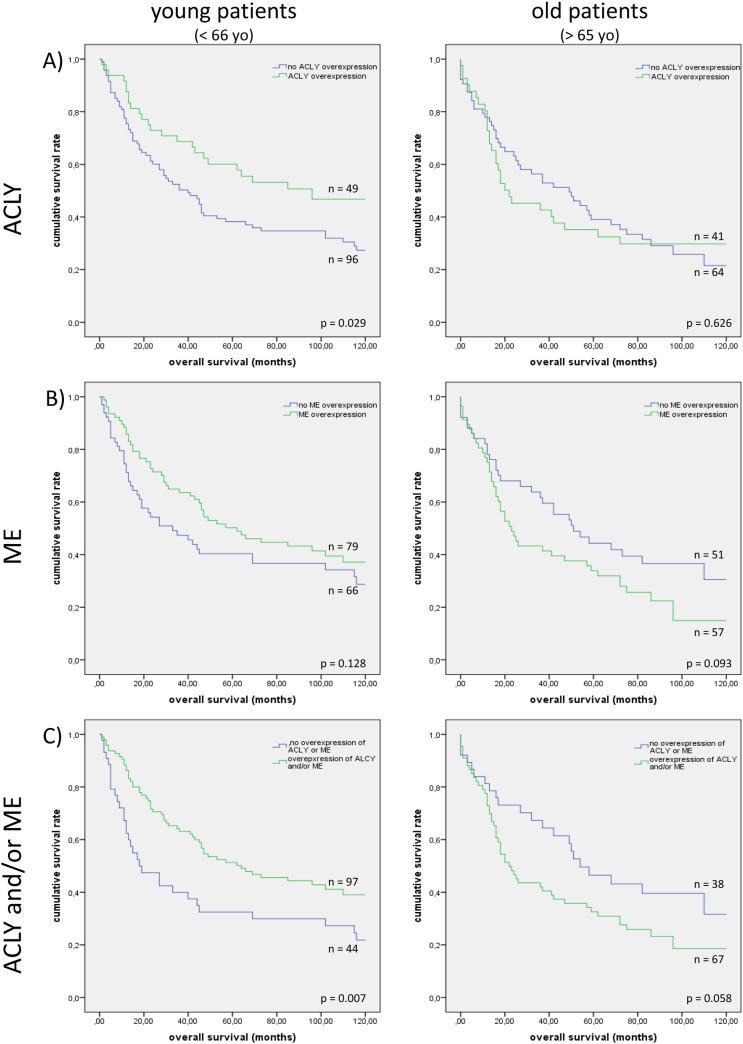
Overexpression of ACLY and ME in correlation with patient’s overall survival.A) Overexpression of ACLY is associated with a better outcome in young patients but not in older patients. B) ME overexpression shows a statistical trend towards a poorer overall survival in older patients. C) Young patients whose tumors revealed either ACLY and/or ME overexpression had a significantly longer overall survival compared to those without overexpression of either enzyme. But in older patients overexpression of either ACLY and/or ME may be associated with poorer overall survival.